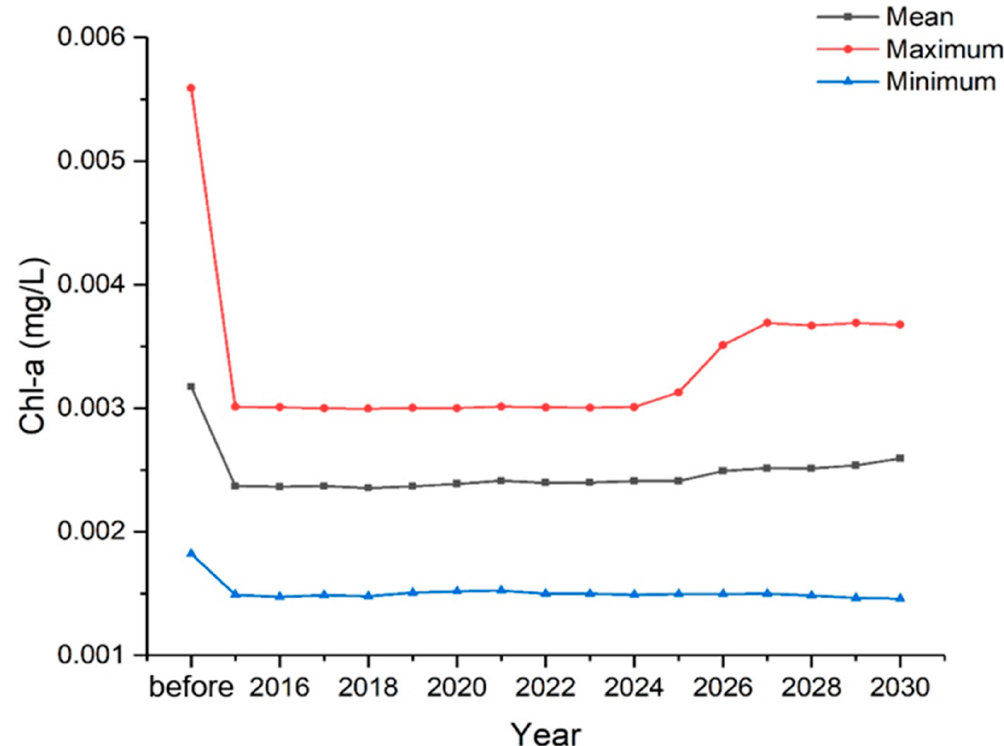
Figure 8. Interannual variations in mean, maximum and minimum Chl-a concentrations of Miyun Reservoir before and after SNWTP implementation (before are mean concentrations from 2009 to 2014).